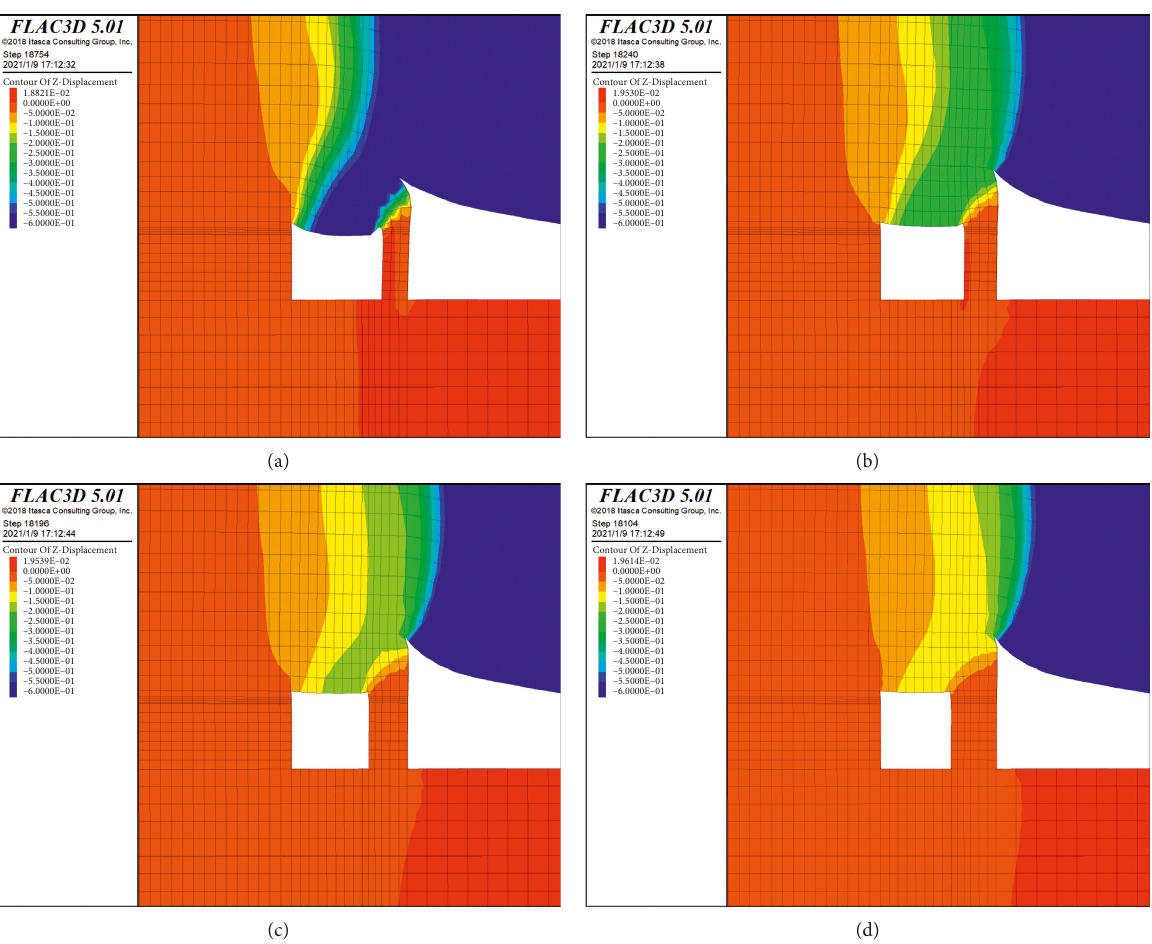
Figure 5: Displacement cloud map of surrounding rock of roadway with different widths of “combined” walls (unit: mm). (a) 1.2mm. (b) 1.5 mm. (c) 1.8 mm. (d)